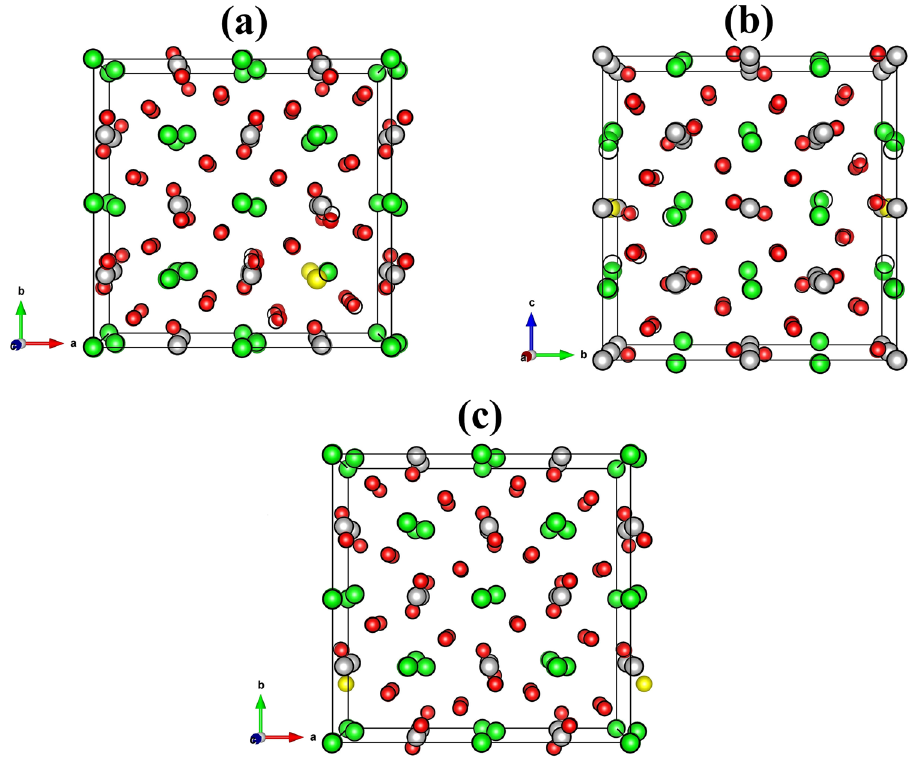
Figure 3. Changes in the positions of atoms before and after the minimization of atomic forces in defective 0 , ( b ) V 0 and ( c ) V 0 vacancies. The unrelaxed atomic positions supercells of CaZrO 3 containing isolated ( a ) V Ca Zr O are represented by solid spheres, while the relaxed atomic positions after the minimization of forces are masked onto these spheres using black rings. A black ring completely encompassing a solid sphere (as an outline) means that the atomic position does not change upon relaxation. Ca, Zr and O atoms are represented by green, gray and red spheres, respectively, while the vacancy site is depicted by a yellow